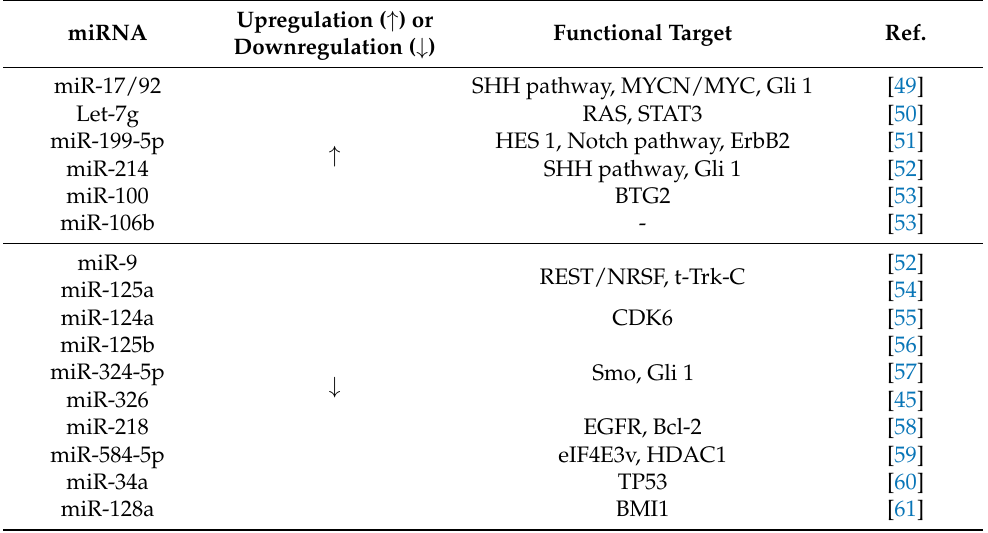
Table 2. Dysregulated miRNAs in MB and their functional